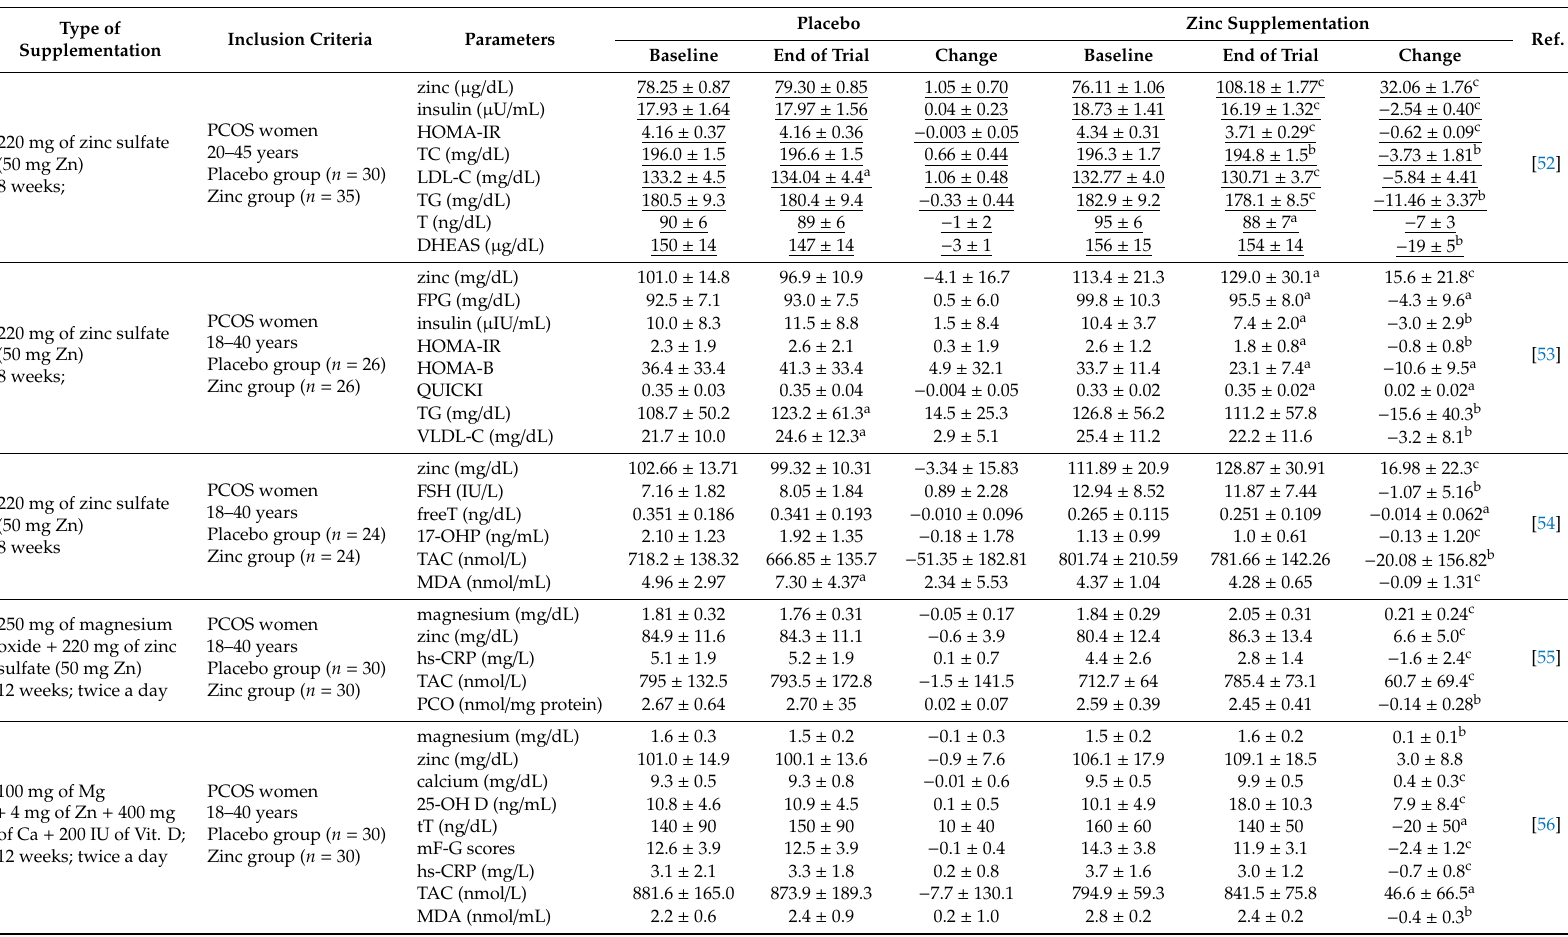
Table 3. The e ff ects of zinc supplementation on various biochemical parameters in women with